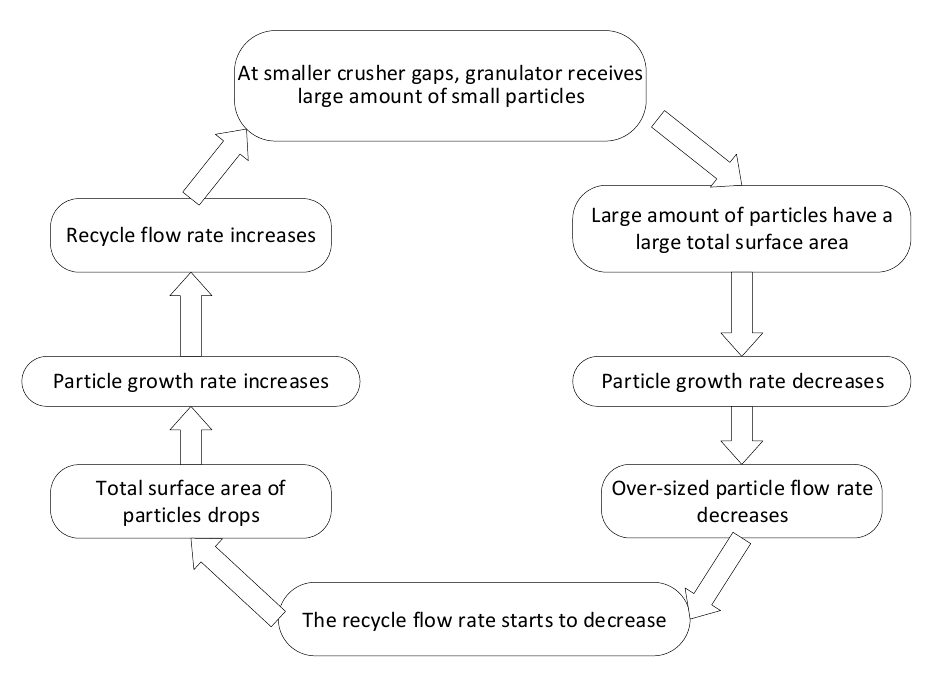
Figure 12: Explanation of the